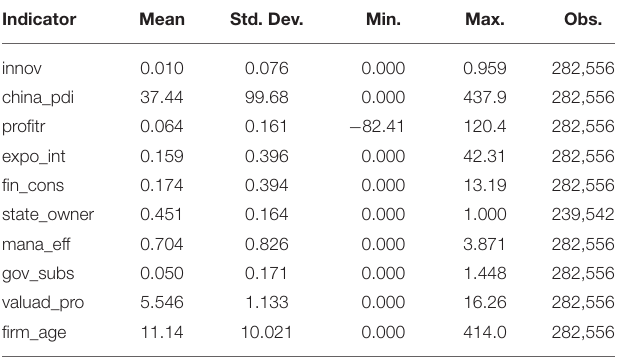
TABLE 2 | Summary of descriptive statistics.